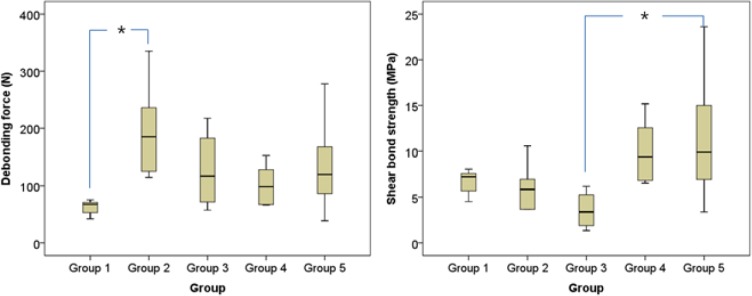
Box slot of debonding force and shear bonding strength.The bottom and top of the boxes are the 25th and 75th percentile respectively of debonding forces and SBS for each group. The band near the middle of the box denotes the median. Upper and lower horizontal lines outside the box represent maximum and minimum values within a 1.5 interquartile range. The superscripts indicate differences in debonding forces and shear bond strength, according to Tukey’s HSD test, at P = 0.05. Group 1, preadjusted bracket; Group 2, Harmony; Group 3, Incognito; Group 4, Insignia; Group 5, Orapix.